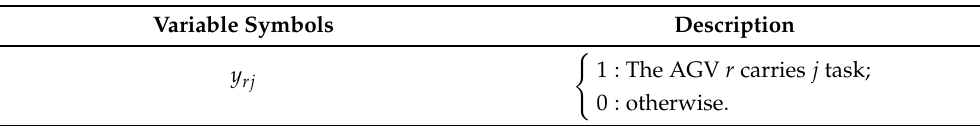
Table A5. Variable symbols description of model static picking order to determine the target shelf (see Section